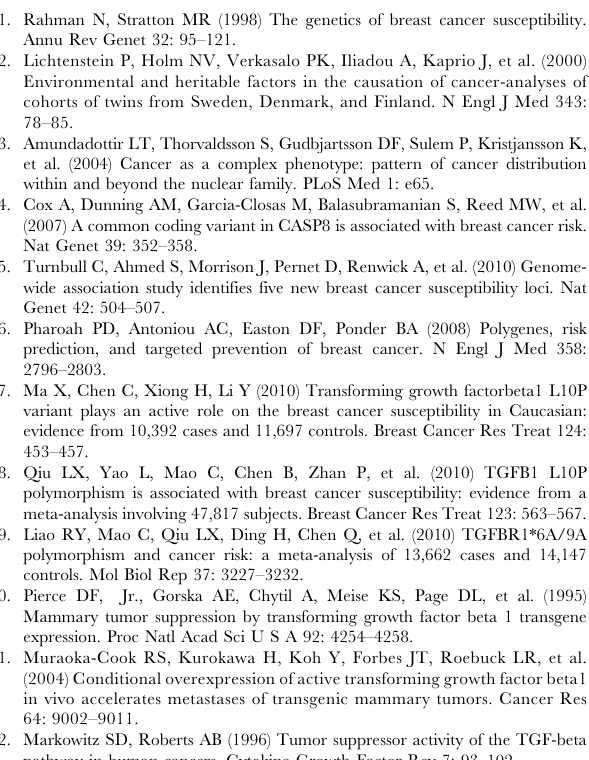
Figure S1 Analysis of association of TGFB1 T29C genotypes with hormone receptor status in Maharash- trian subjects. OR – Age adjusted odds ratios with 95% CI;